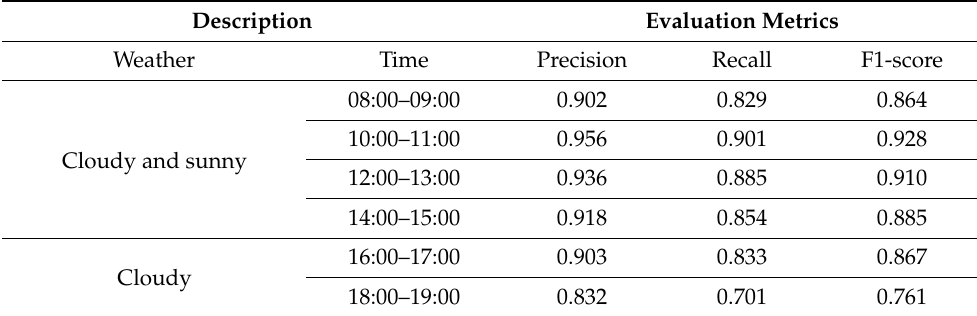
Table 3. Using deep learning models to detect weeds during the daytime. Description Evaluation Metrics Weather Time